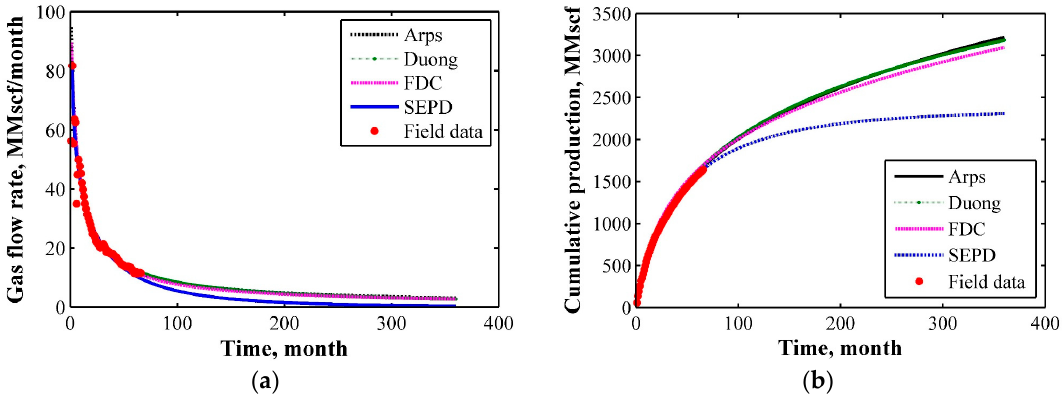
Figure 6. Comparison results for one well from Fayetteville shale. The red dots are the original field data. ( a ) The matching results for monthly flow rate; ( b ) the EUR results of DCA